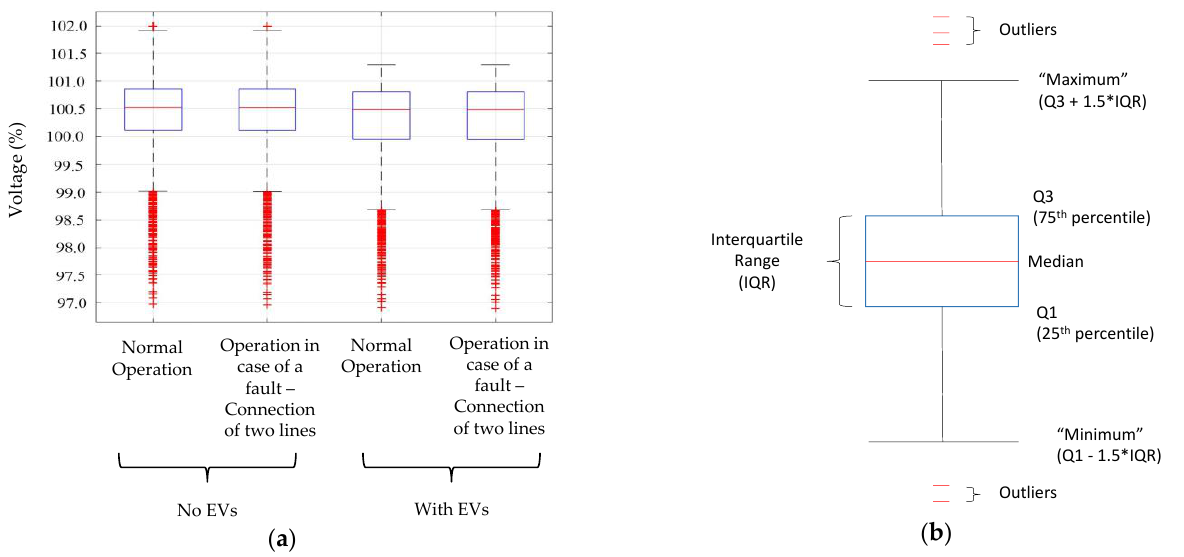
( b ) Figure 9. Voltage values for various EV penetration scenarios in the island of Ikaria (a 1 MW wind generator is considered to operate in the island for the scenarios examined): ( a ) minimum voltage value and ( b ) voltage deviation [48]. However, such investments can be avoided with smart charging strategies. For in- stance, when considering the application of a valley filling scheme (i.e., EV charging is distributed during the night hours in order to avoid spikes in the system’s load) in the case of Ikaria [48] (green bars in Figure 9a,b), an increased number of EVs can enter the grid without causing any voltage violation issue. 4.4. Exploiting EV – RES Synergies towards Increasing the RES Penetration